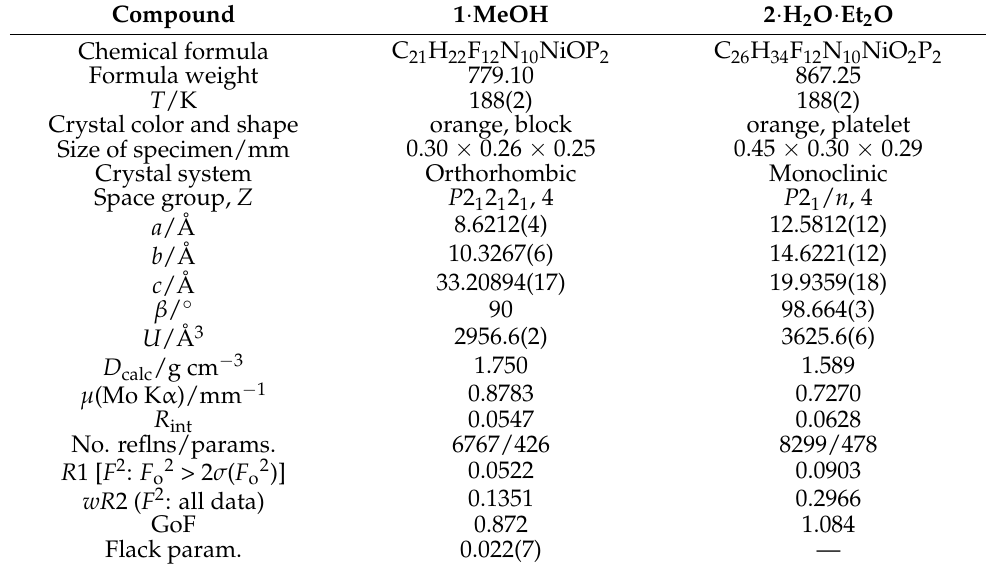
Table 1. Crystallographic data of compounds 1 · MeOH and 2 · H 2 O · Et 2 O.